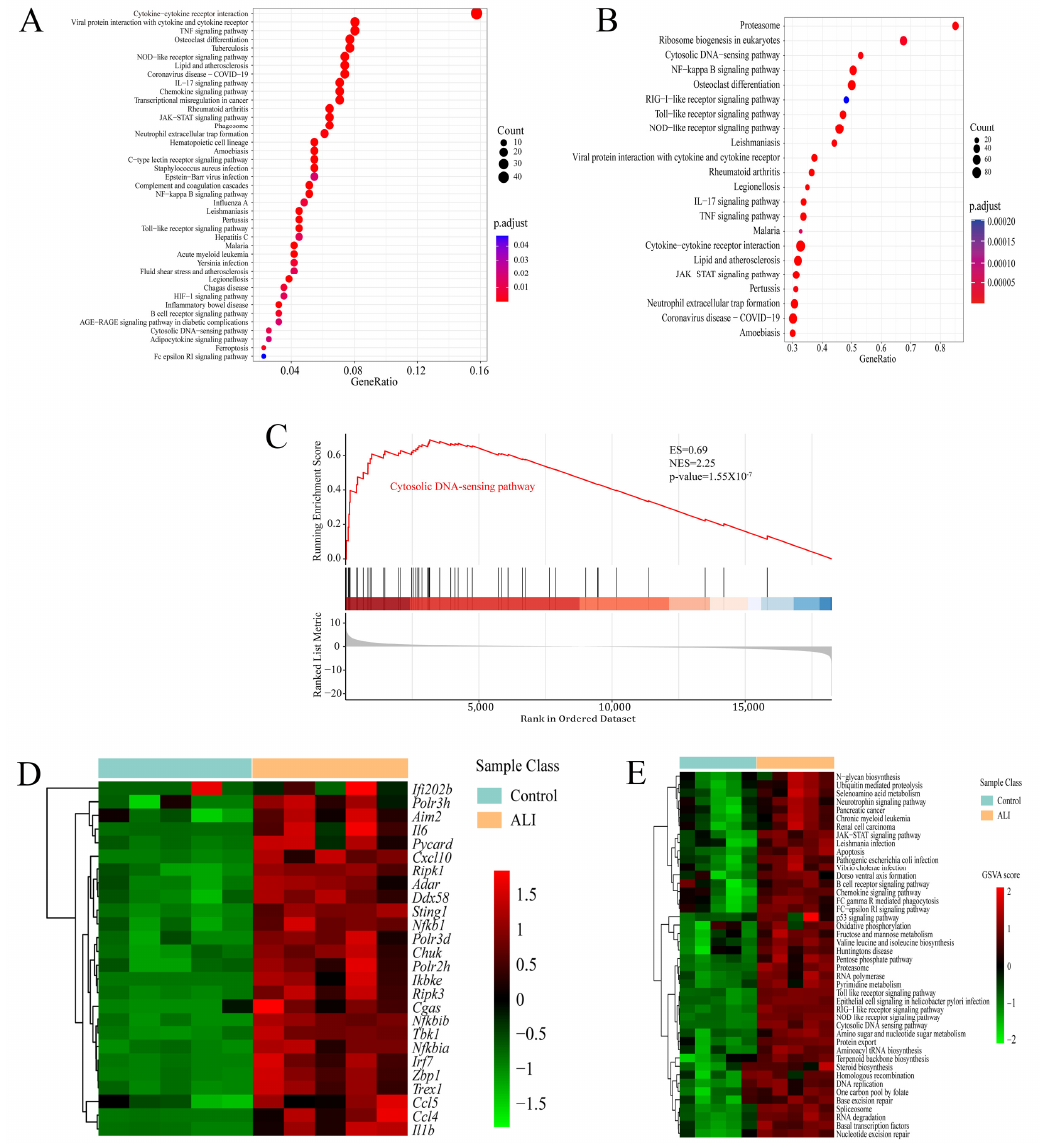
Figure 3. RNA-seq analysis suggests that the cytosolic DNA sensing pathway is up-regulated in acute lung injury. Lungs from the ALI model and control were obtained to perform RNA-seq analysis. ( A ) Bubble chart of KEGG enrichment analysis for significantly up-regulated genes in ALI (log2 foldchange > 2 and adjust p < 0.01). ( B ) Bubble chart of KEGG enrichment in GSEA showing up- regulated pathways in ALI (NES > 2 and p -value < 0.05). The ordinate indicates the terms of the enriched pathways, the abscissa indicates the GeneRatio and the size of the bubble corresponds to the count of genes in each term. The color intensity of the bubble indicates adjust p , while the intensity follows the color bar on the right. ( C ) Enrichment plot of the cytosolic DNA sensing pathway from GSEA comparing ALI vs. control. ( D ) Heatmap showing the core genes enriched in GSEA in the cytosolic DNA sensing pathway. The abscissa indicates the sample number, the ordinate indicates the differentially expressed genes, the right histogram indicates the color scale and each rectangle in the panel corresponds to the expression value in one sample. ( E ) Heatmap showing KEGG pathways up-regulated in ALI based on GSVA. The abscissa indicates the sample number, the ordinate indicates the KEGG pathway term, the right histogram indicates the color scale and each rectangle in the panel corresponds to the GSVA score. ALI = acute lung injury; KEGG = Kyoto Encyclopedia of Genes and Genomes; GSEA = gene set enrichment analysis; GSVA = gene set variation analysis; NES = normalized enrichment